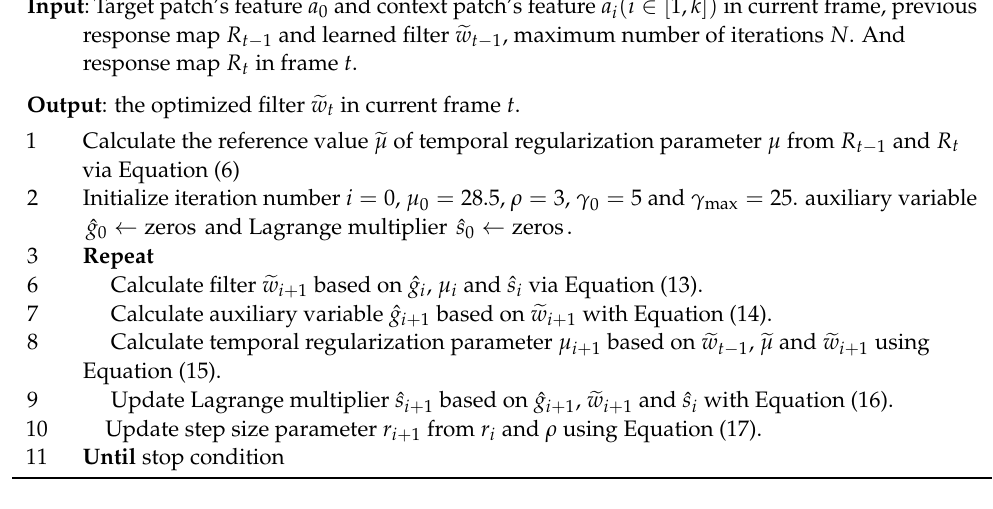
Algorithm 1 The filter optimization using ADMM in frame t